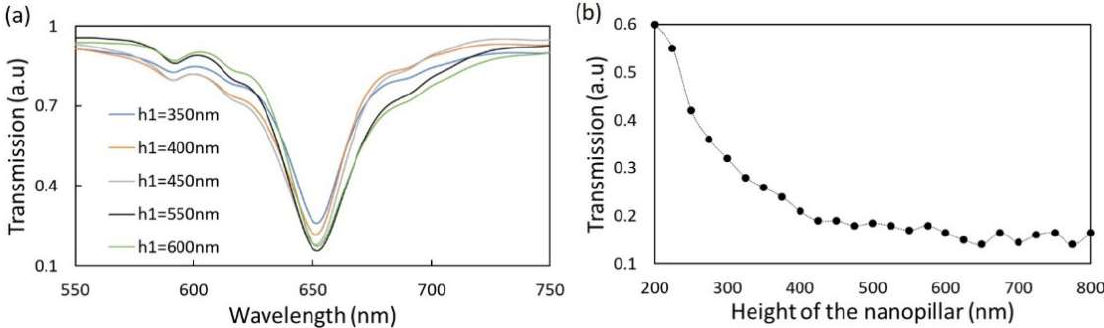
Figure 3. ( a ) The transmission spectra of Au nanoantennas on SiO 2 nanopillars for different heights of the nanopillars, for a geometry depicted in Figure 1. ( b ) The variation of the transmission dip with a periodic increase in the height of the nanopillars.